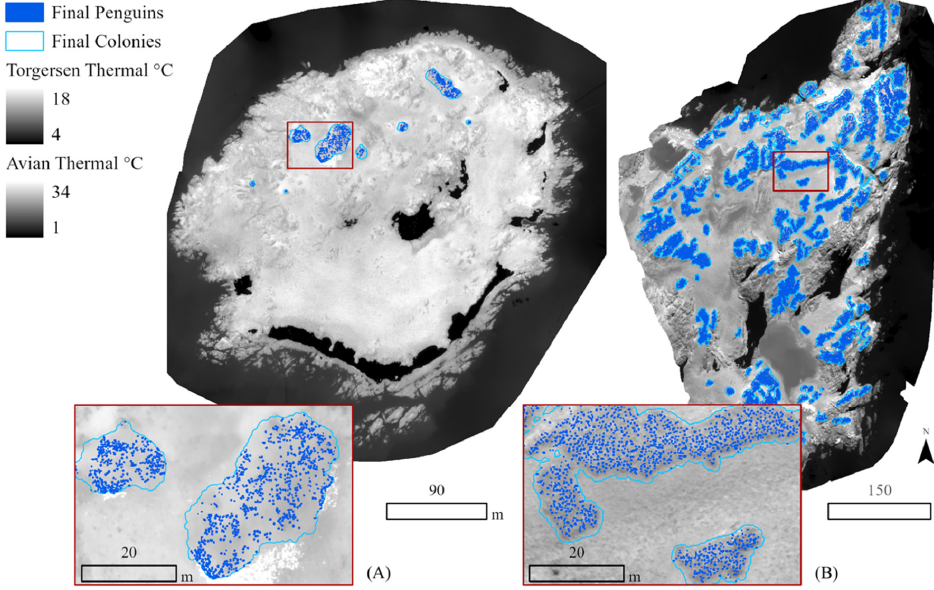
Figure 3. Final output of workflow on both islands. Thermal imagery of ( A ) Torgersen Island and ( B ) Avian Island study sites. The final colonies isolated using the polygons from the multispectral imagery are outlined in light blue. Individual penguins isolated using thresholding and high pass filtering are shown in dark blue.